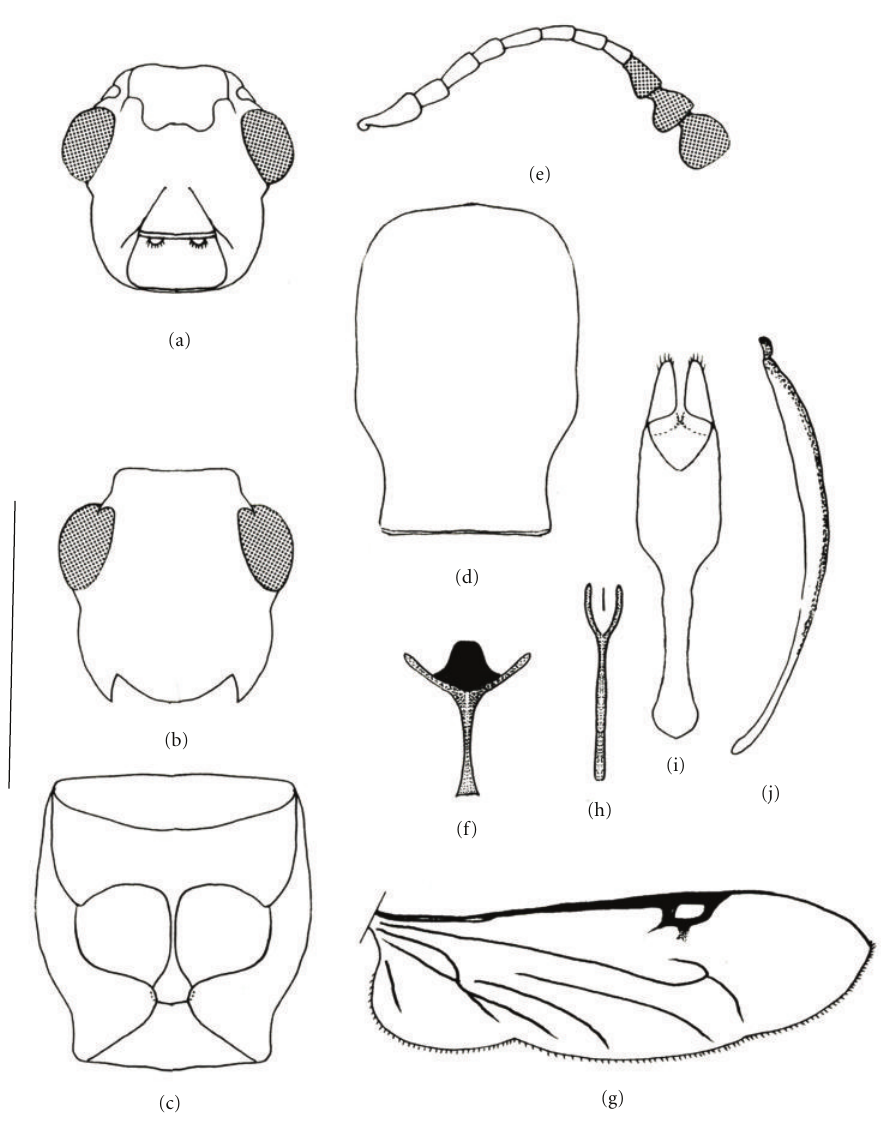
Figure 17: Various organs of Tarsostenodes simulator . (a, b) Head ((a) ventral, (b) dorsal). (c, d) Pronotum ((c) ventral, (d) dorsal). (e) Antenna. (f) Metendosternite. (g) Metathoracic wing. (h) Spiculum. (i) Tegmen. (j) Phallus.